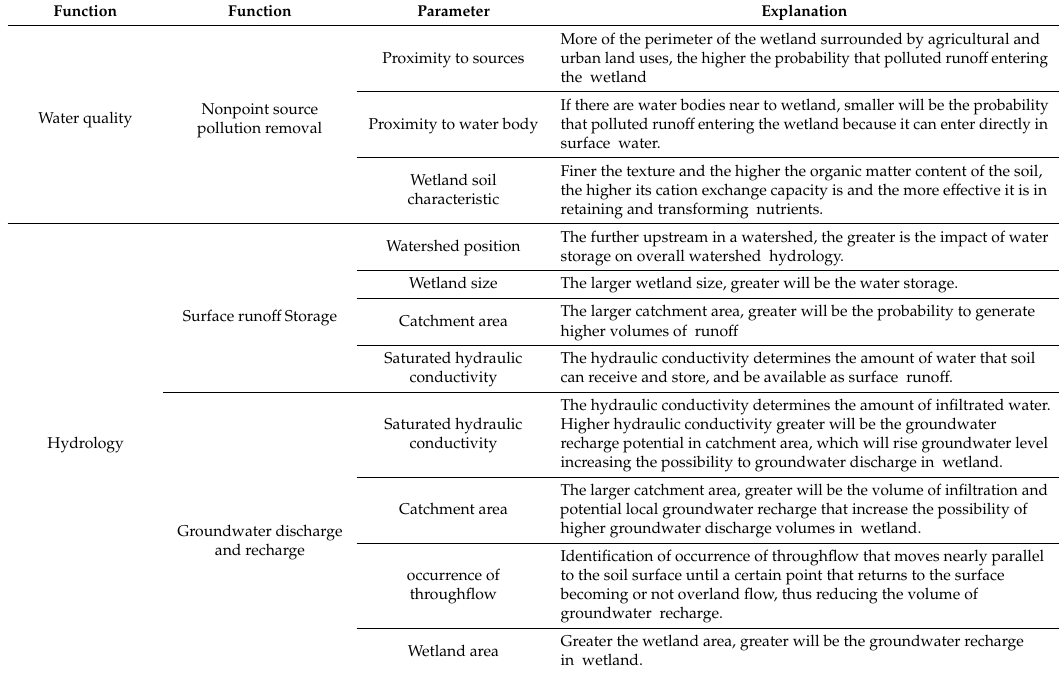
Table 2. Parameters and respective assumptions considered to analyze the significance of wetland functions.